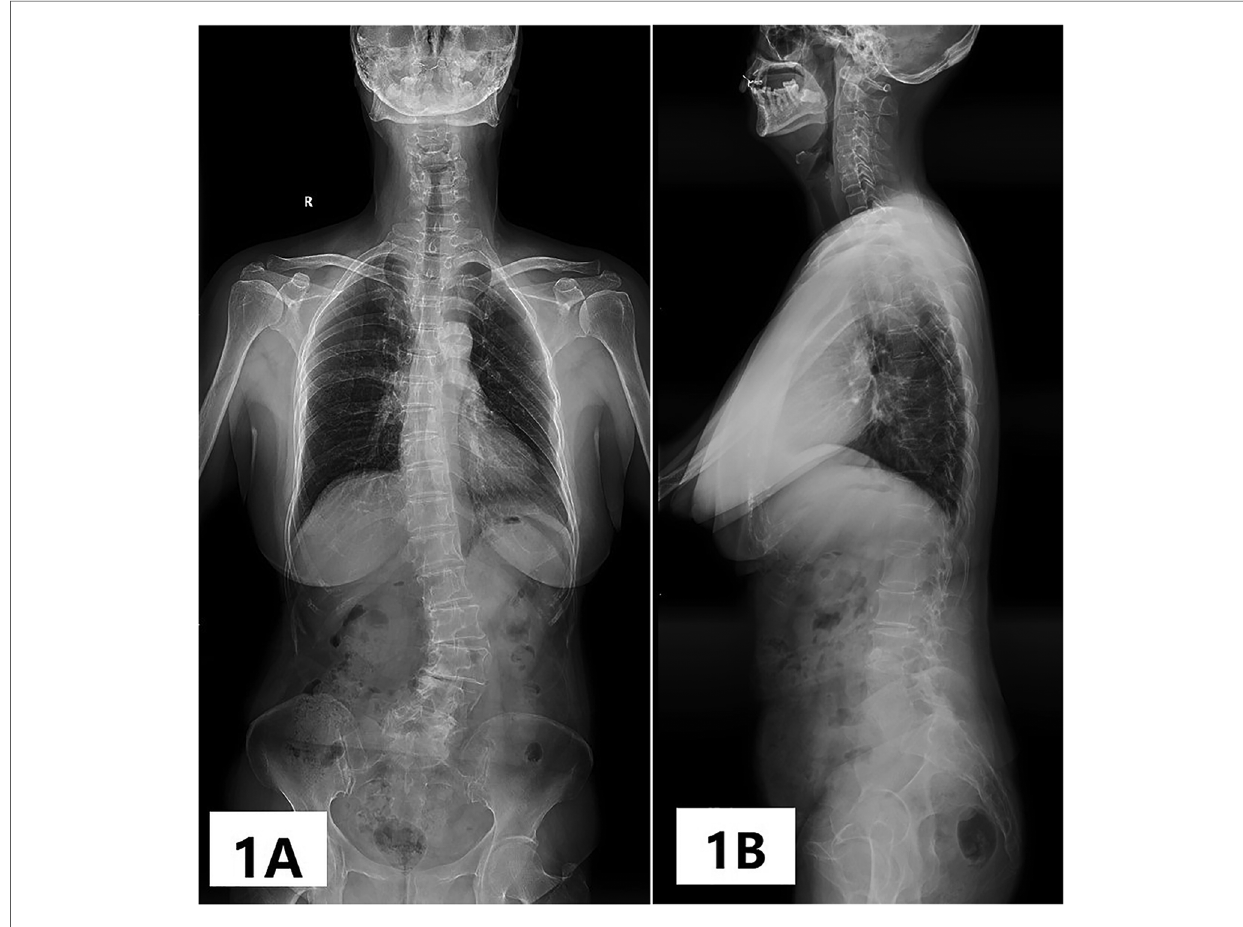
FIGURE 1 ( A ) Apical vertebrae was L3 vertebrae, the scoliosis Cobb ’ s angle was 40°, and the coronal plane was imbalanced; the main curve was located on the lumbar segment with left scoliosis, and the compensatory curve whose orientation was opposite to the main curve was located on the